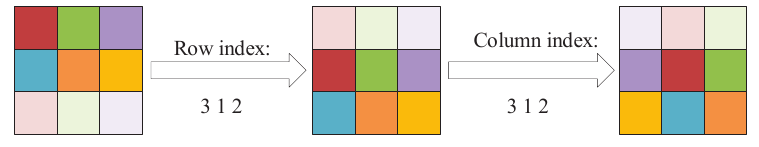
Figure 2. Flowchart of matrix